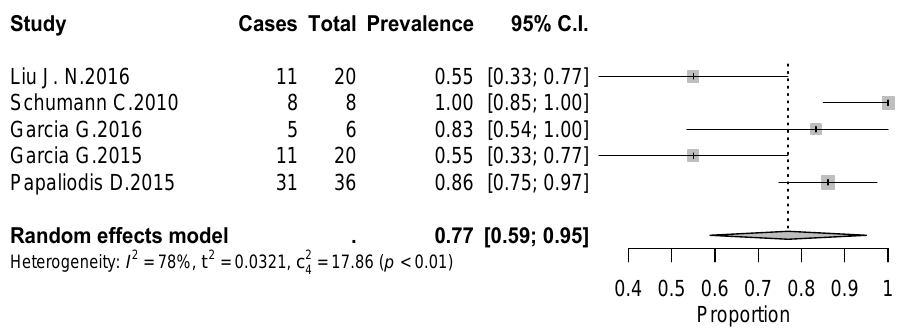
Figure 6. Forest plot chart of the rate of return to golf after shoulder arthroplasty with 95% confidence interval.